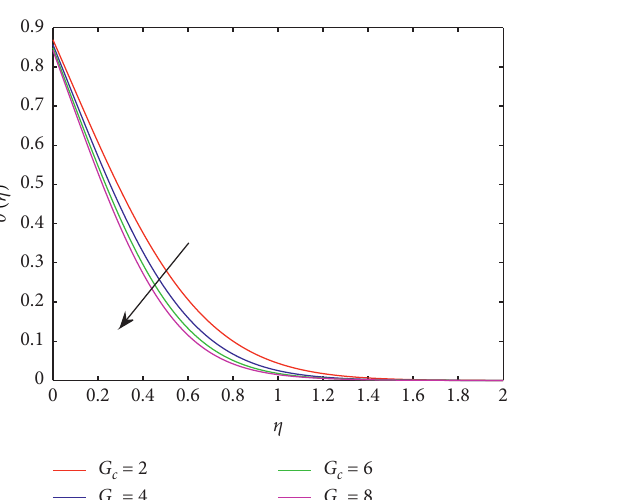
Figure 14: Variation due to G